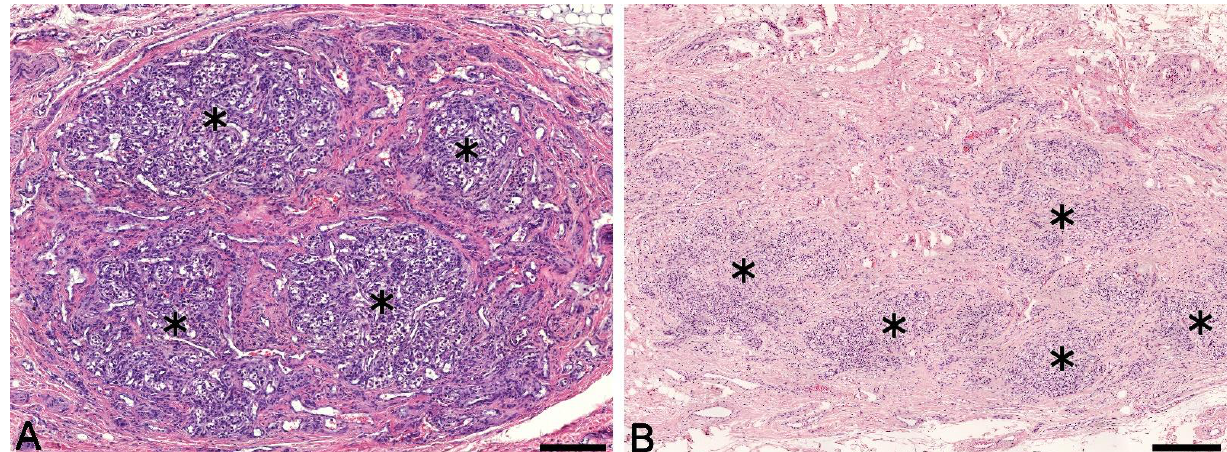
Figure 2. The human carotid body in the postnatal period. ( A ) The 24-year-old woman. ( B ) The 86-year-old woman. Asterisks represent lobules. H&E stain. Left bar = 200 µ m; right bar = 400 µ m.